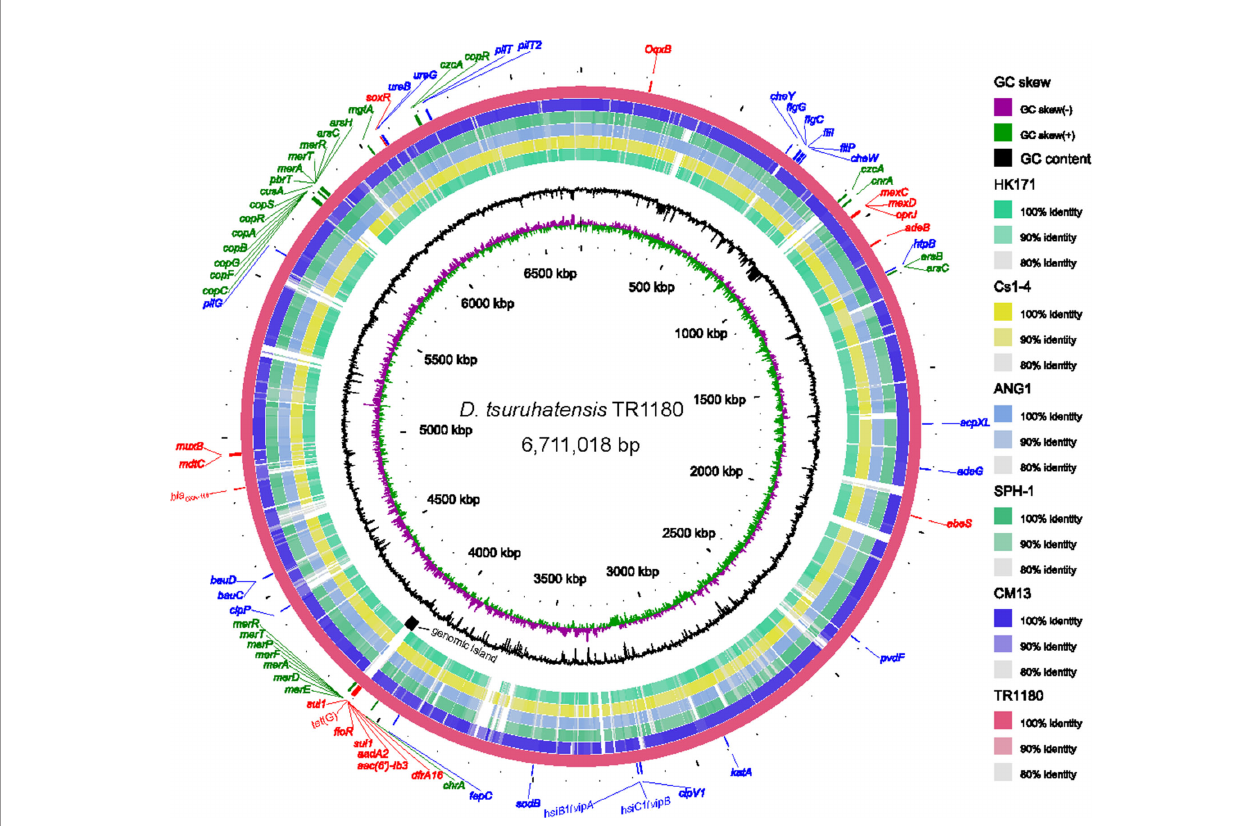
FIGURE 2 | Circular representation of the D. tsuruhatensis TR1180 genome and comparative genomics analysis with other Delftia strains generated by BRIG. Counting from the outside toward the center: circle 1 shows AMR genes (colored in red), virulence genes (colored in blue) and metal resistance genes (colored in green) encoded on the TR1180 genome; circle 2 indicates the complete genome of TR1180 (as the reference genome); circles 3-7 refer to regions of D. tsuruhatensis CM13 (CP017420), D. acidovorans SPH-1 (CP000884), D. acidovorans ANG1 (CP019171), D. sp. Cs1-4 (CP002735) and D. sp. HK171 (CP018101) which have high sequence similarities (>80%) with D. tsuruhatensis TR1180, where empty regions indicate parts without similar hits between them; circle 8 displays the speci fi c genomic island in TR1180; circles 9 and 10 represent GC content and GC skew of TR1180,